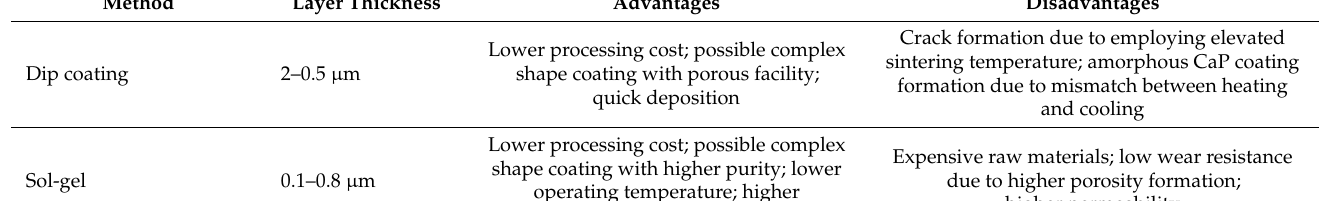
Table 7. Comparative study between commonly used coating techniques and the PM-EDM method [11,19,48].